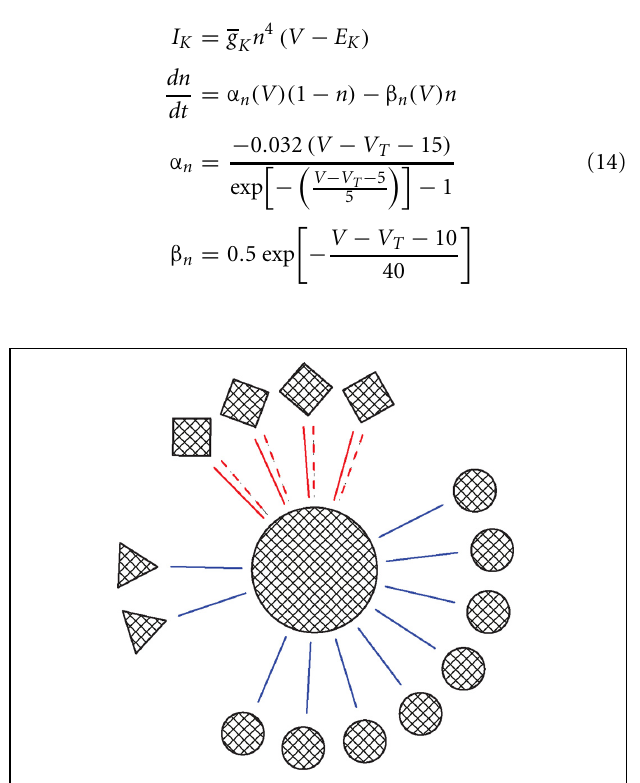
FIGURE 1 | Schema of the network. Circles, squares and triangles represent GP, STN, and Str neurons, respectively. Blue solid lines represent ionotropic GABAergic synapses, red solid lines represent ionotropic glutamatergic synapses and red dashed lines represent metabotropic glutamatergic synapses. The ratio of the various neuron types in the figures was that in the full